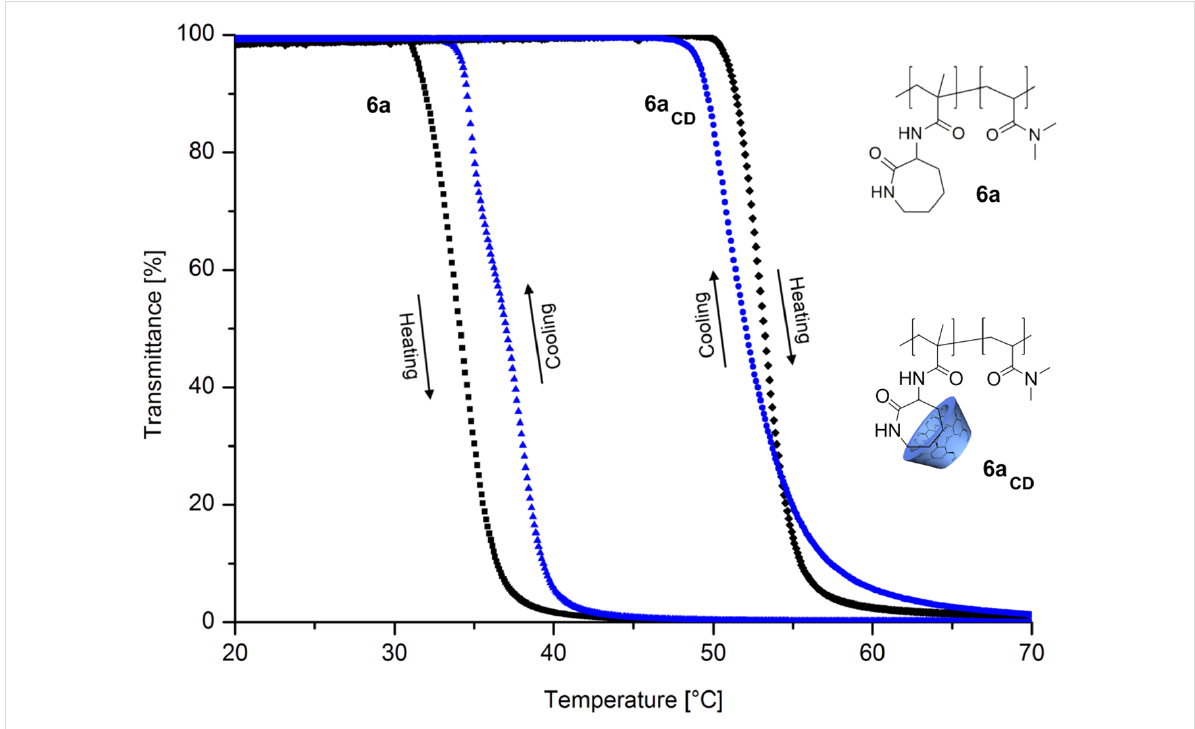
Figure 1: Turbidity curves upon heating and corresponding curves upon cooling of 10 mg ml − 1 solution of polymer 6a and 6a CD at a heating/cooling rate of 1 °C min − 1 .